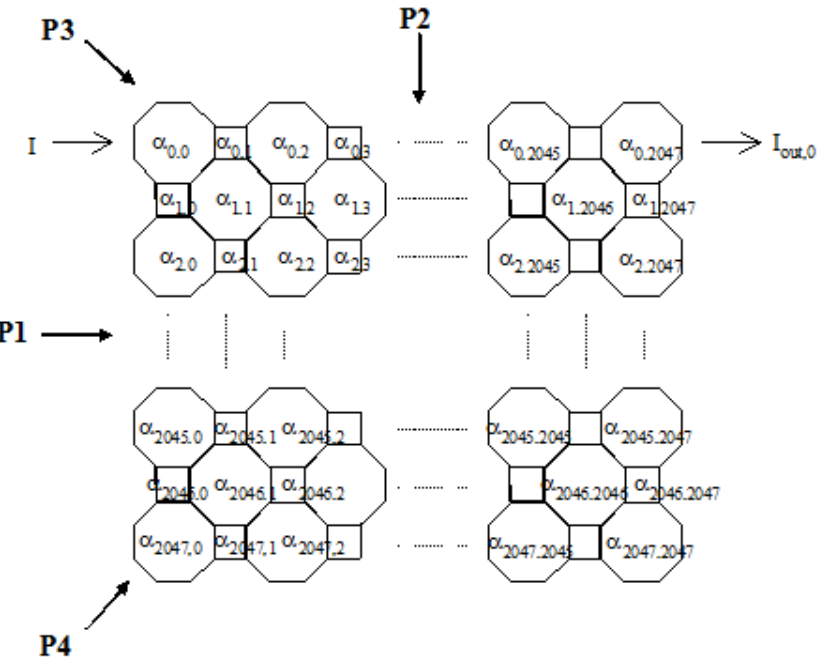
Figure 8. 2,048 by 2,048 array of pixels with four